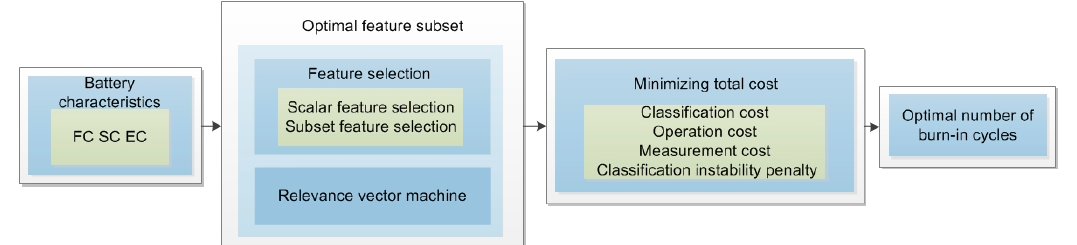
Figure 2. Block diagram of the proposed optimal burn-in policy.